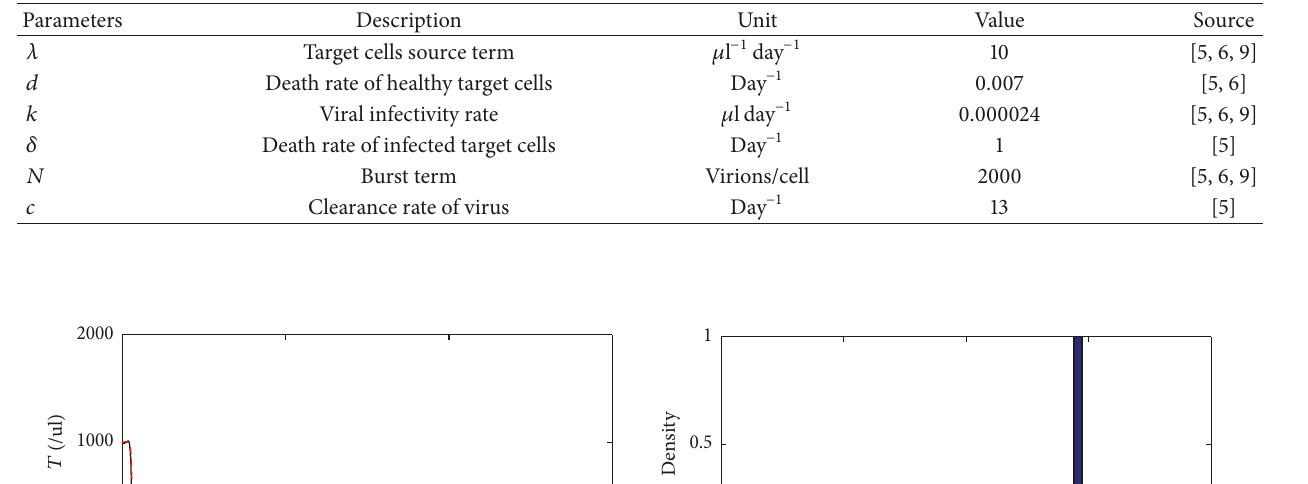
Table 1: List of parameters.